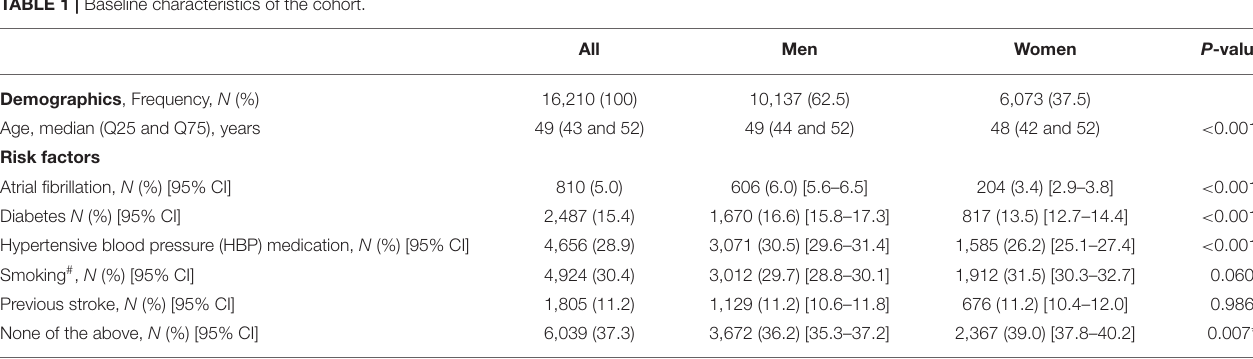
TABLE 1 | Baseline characteristics of the cohort.